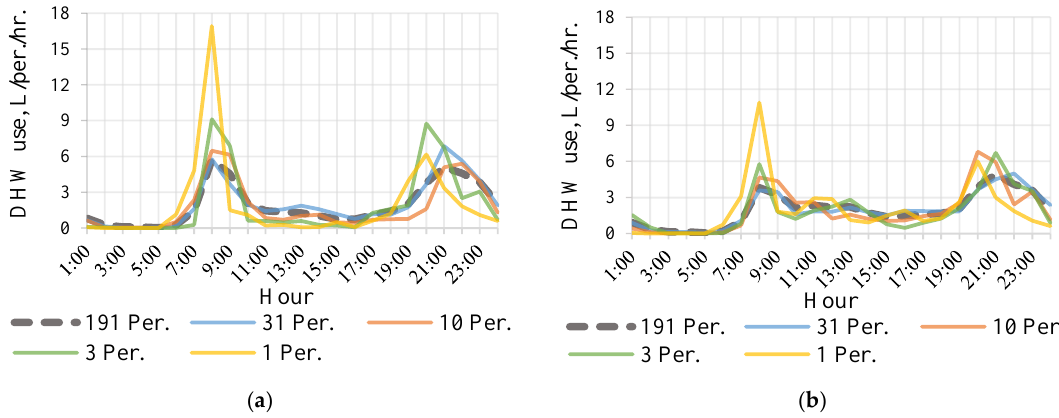
Figure 2. Proposed profiles of five groups for the month of November ( a ) weekday, ( b ) total day (all days that include weekdays and